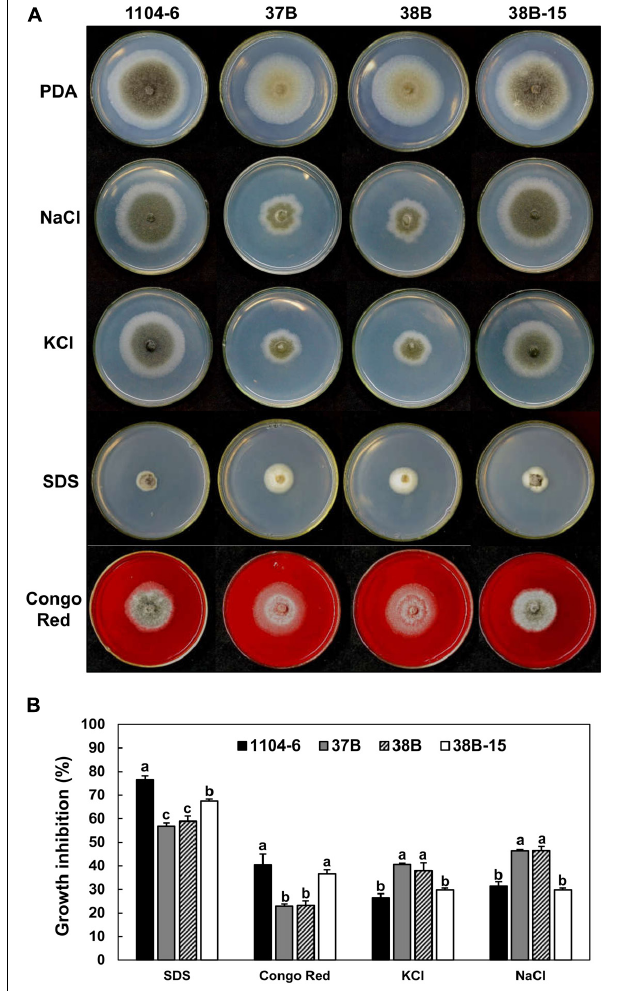
FIGURE 7 | The CfPMK1 gene functions in stress tolerance. (A) Colony morphologies of different strains growing on PDA and PDA amended with different stress compounds. Typical colonies were photographed at 4 dpi. (B) Barplot showing variation in growth inhibition of different strains to stress compounds. Growth inhibition was calculated based on growth rates on PDA and PDA supplemented with chemical compounds, bars and error bars represent means ± standard deviations ( n = 3). Different letters above the error bars indicate significant difference at P = 0.05 according to Tukey’s HSD test following one-way ANOVA analysis.